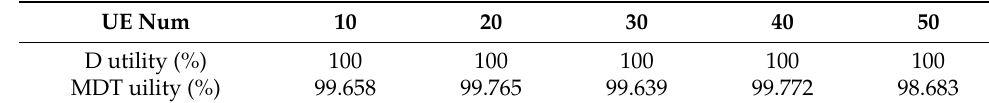
Table 2. Satisfaction of CBR.